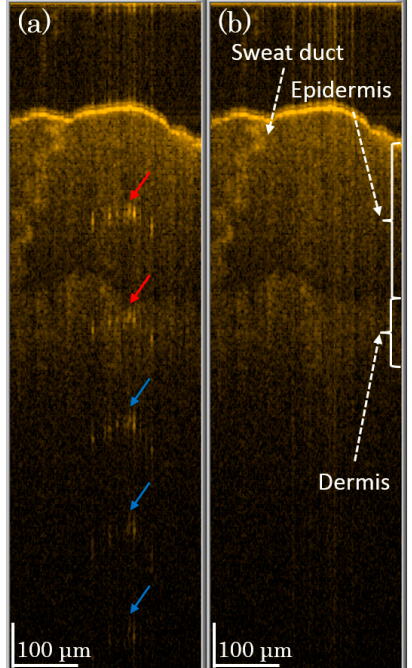
Figure 6. B-mode scan images of the skin of a human finger ( a ) without saturation artifact correction and ( b ) with the two-level compensation